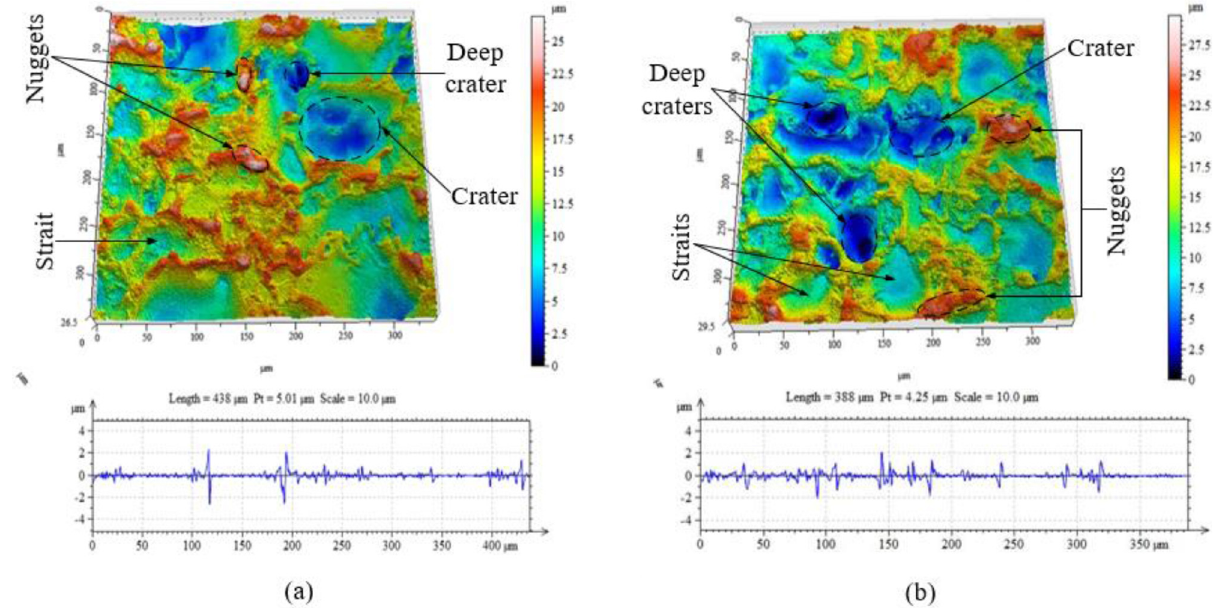
Fig. 8. High resolution CCI image of the machined surface (a) T on = 0.5 m s (b) T on =0.9 m